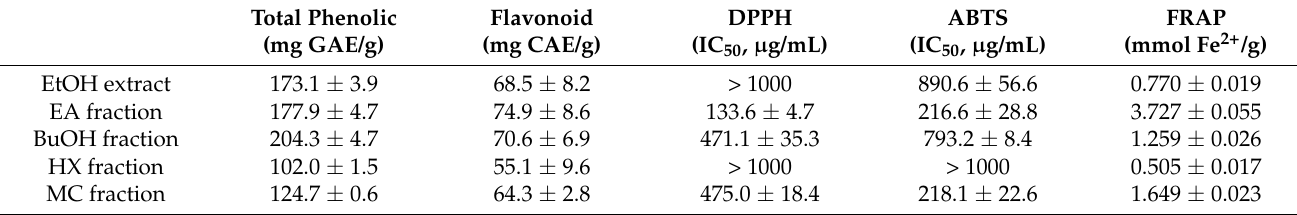
Table 1. Total phenolic and flavonoid contents and antioxidant activities of EtOH extract and fractions of white mulberry fruits a